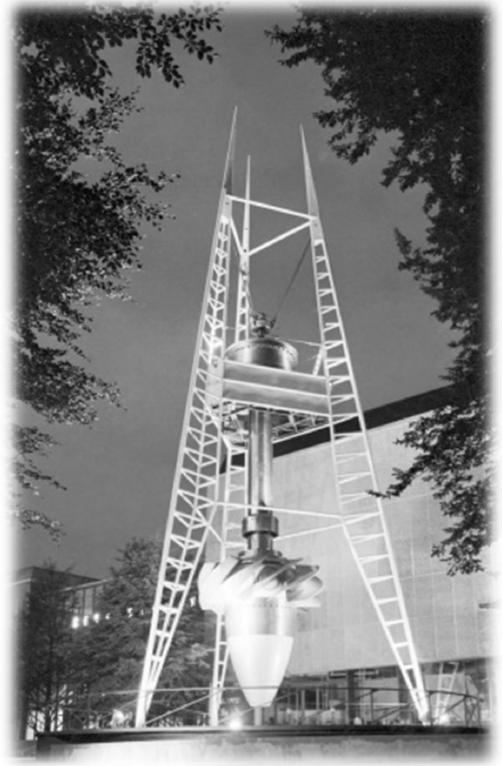
Figure 14. Kaplan turbine at the world exhibition, Expo 58. Source: